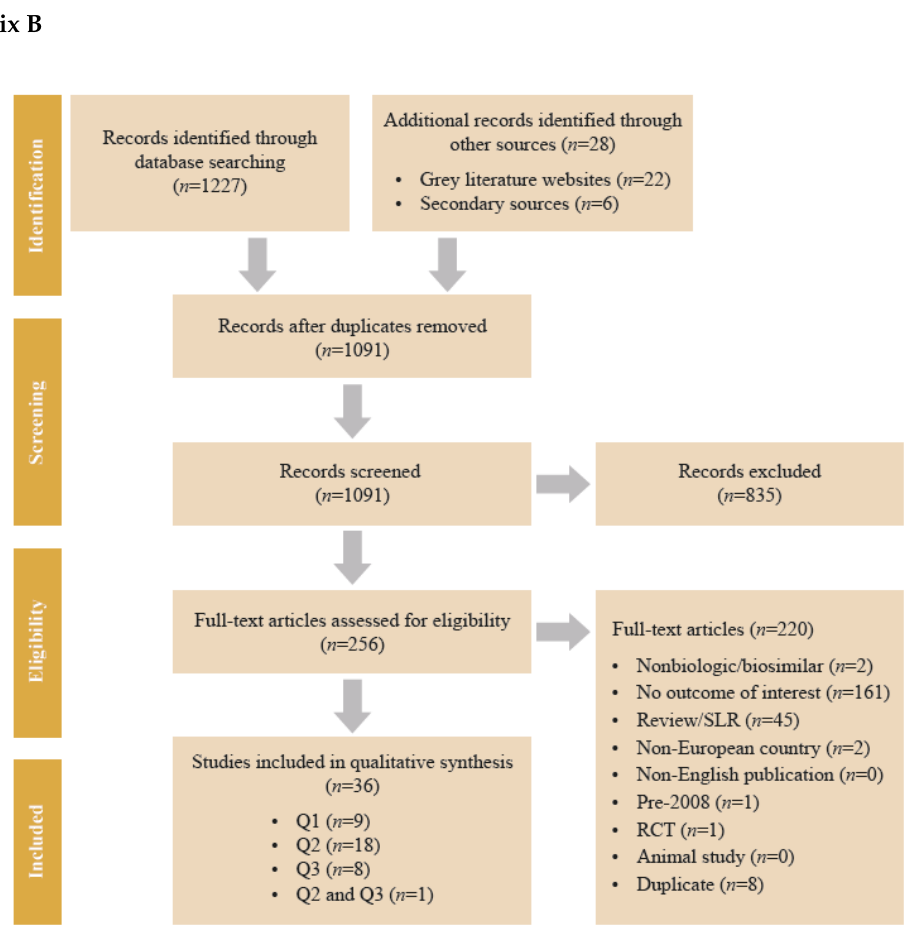
Figure A1. PRISMA Flow Diagram. RCT, randomized controlled trial. SLR, systematic literature review.